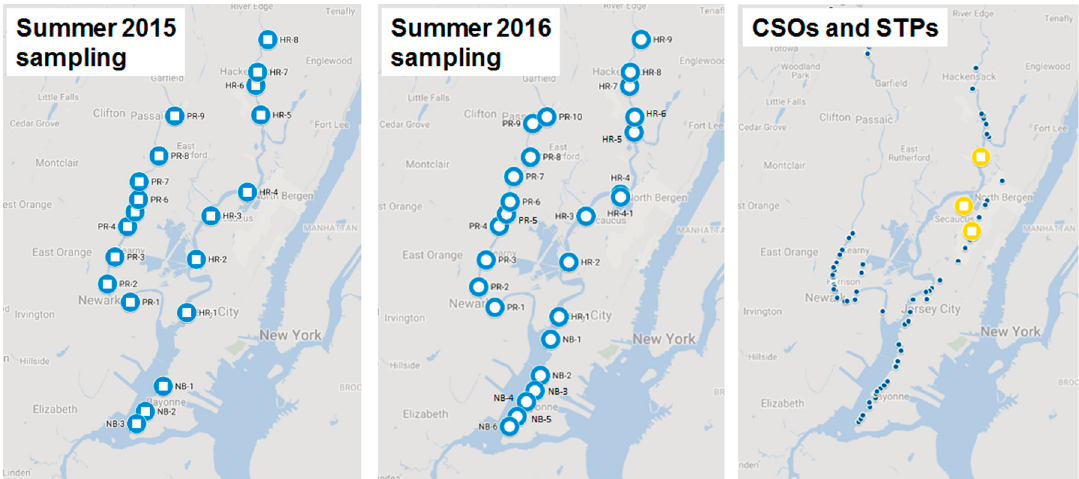
Figure 1. Sampling locations of water and sediment samples from the Newark Bay Estuary (NB: Newark Bay; HR: Hackensack River; and PR: Passaic River) in summer 2015 and 2016, as well as locations of combined sewer overflows (CSOs) outfalls (small blue circles) and sewage treatment plants (STPs; large yellow circles). Note that sediment samples were collected not from all locations (see Tables 4 and 5 for sampling locations for sediments).